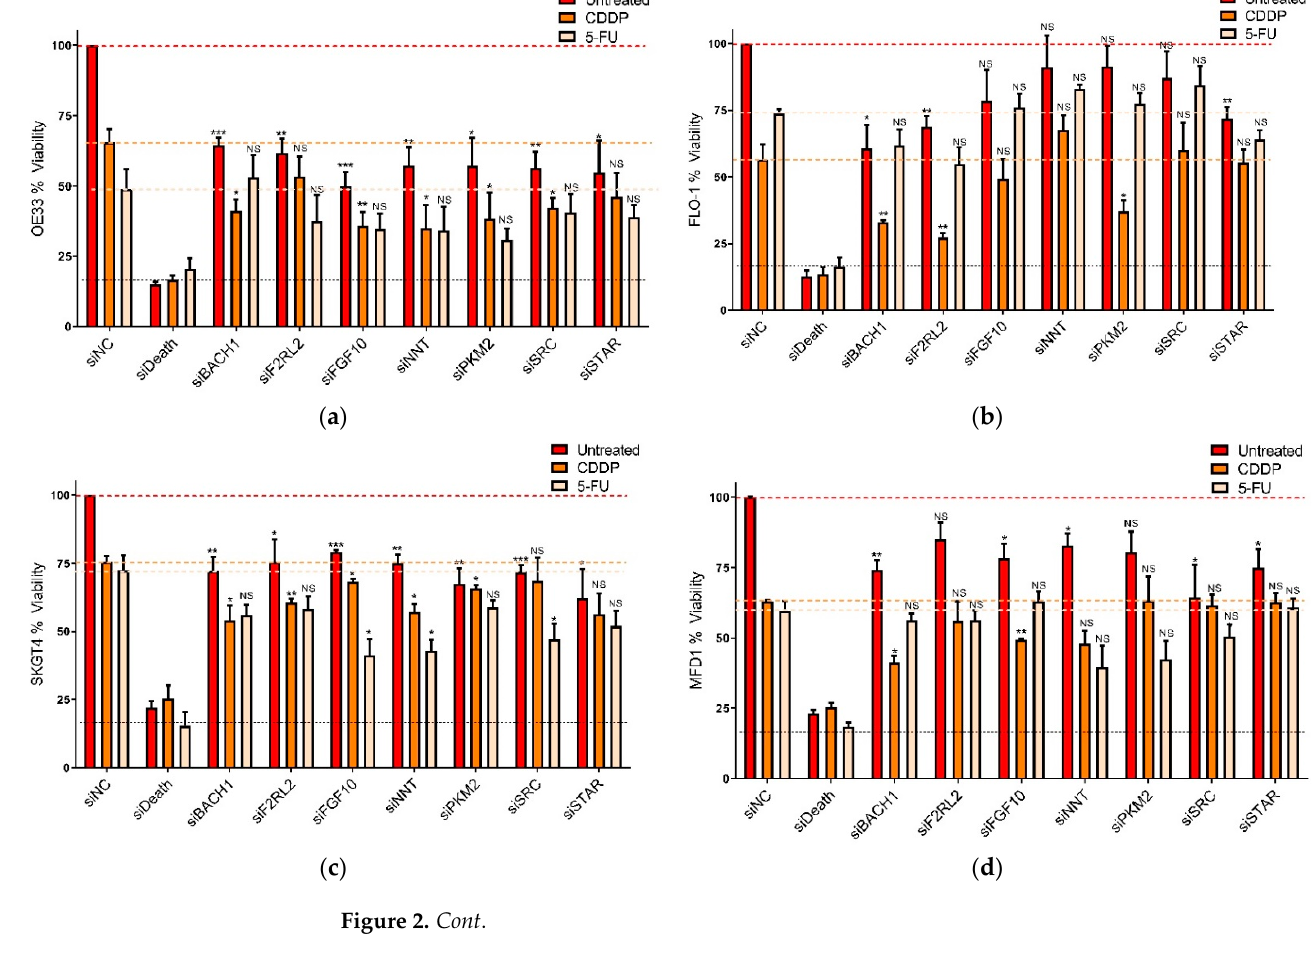
Figure 1. Candidate genes for siRNA screen. A total of 80 out of 784 enriched genes identified by